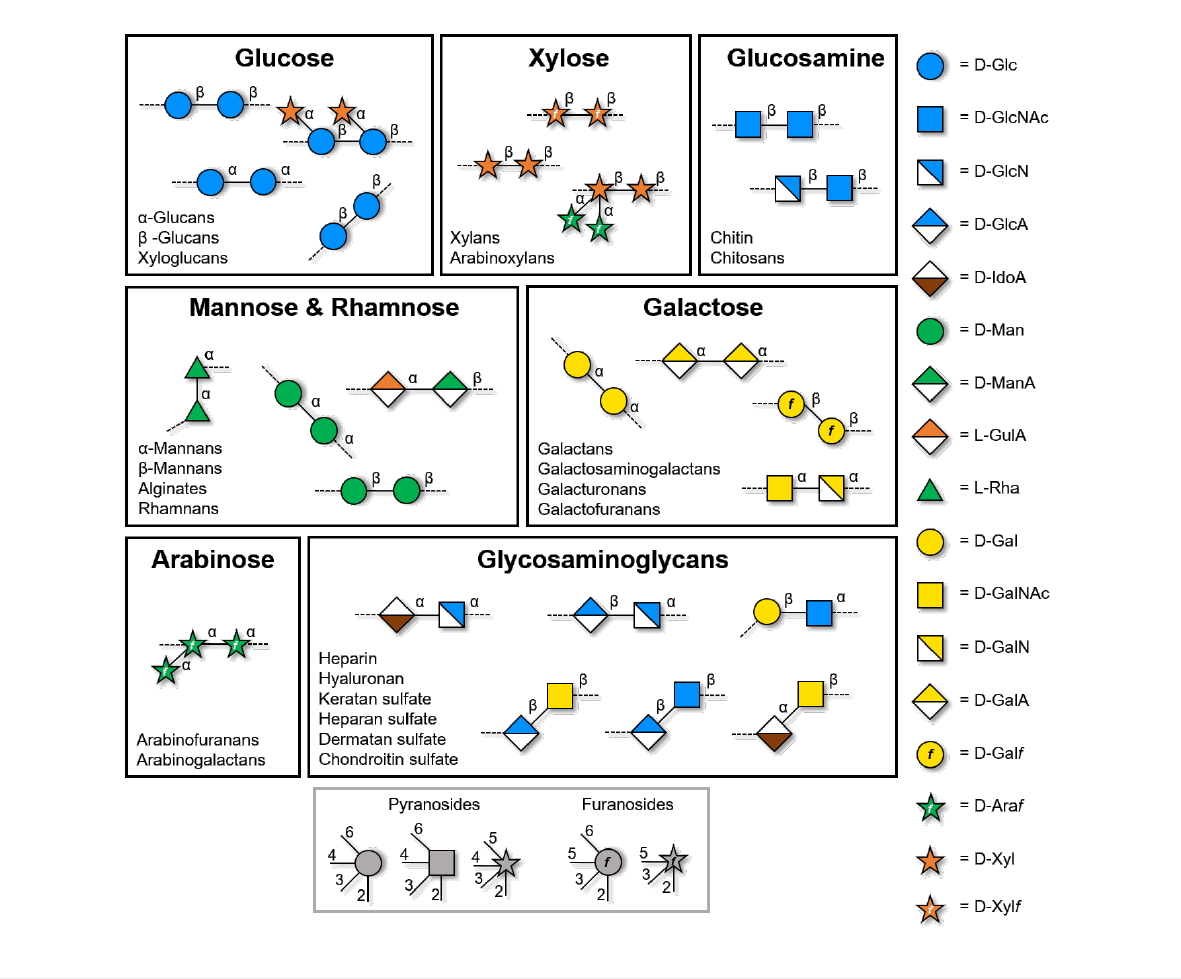
Figure 2: Overview of the classes of polysaccharides discussed in this review. Each section deals with polysaccharides built on the same monosac- charide backbone. Representation following the Symbol Nomenclature For Glycans (SNFG) [41].